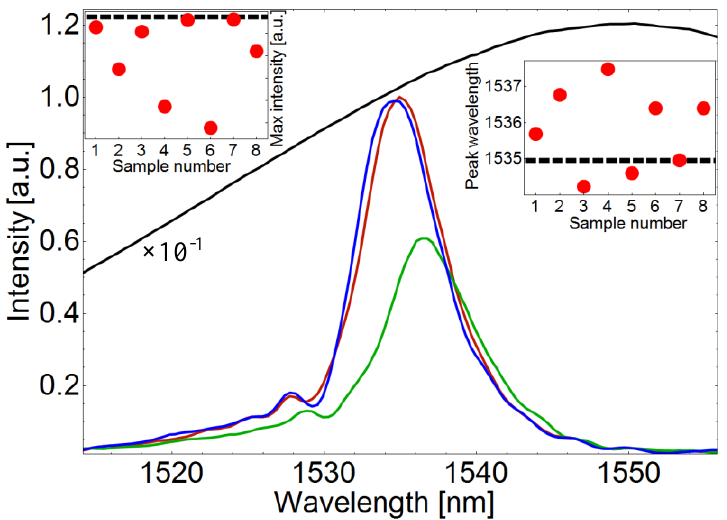
Figure 5. Spectral features of the as-fabricated MMI devices. The solid black line corresponds to the spectrum of the SLD source rescaled by a constant factor of 10 − 1 to emphasize spectral narrowing. The red solid line corresponds to the MMI device prior to CNTs deposition. Solid blue and green lines correspond to reflection spectra of CNTs deposited MMI device using M-SW and M-SW-PVP samples respectively. The left panel shows the maximum intensity as the function of the sample number used for the deposition experiments. The dashed line in the left panel corresponds to the maximum intensity of the spectrum of the bare MMI device. The right panel shows the peak wavelength as the function of the sample used in the laser-induced CNTs deposition experiments. The dashed line in the right panel corresponds to the peak wavelength of the bare MMI device.